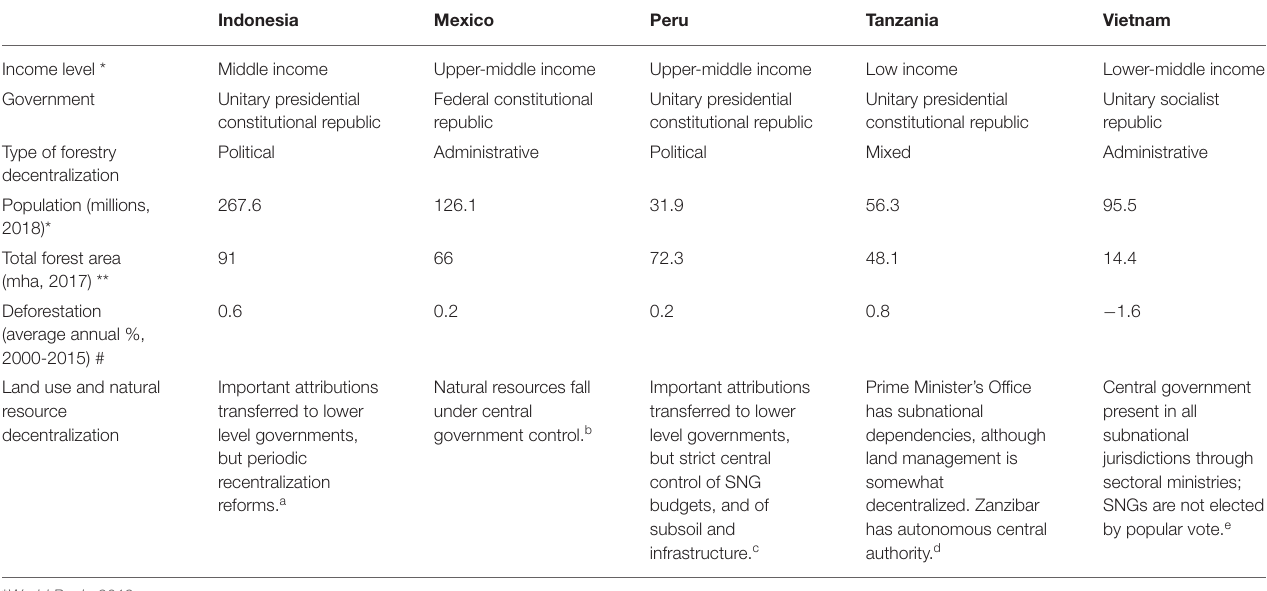
TABLE 2 | Selected country